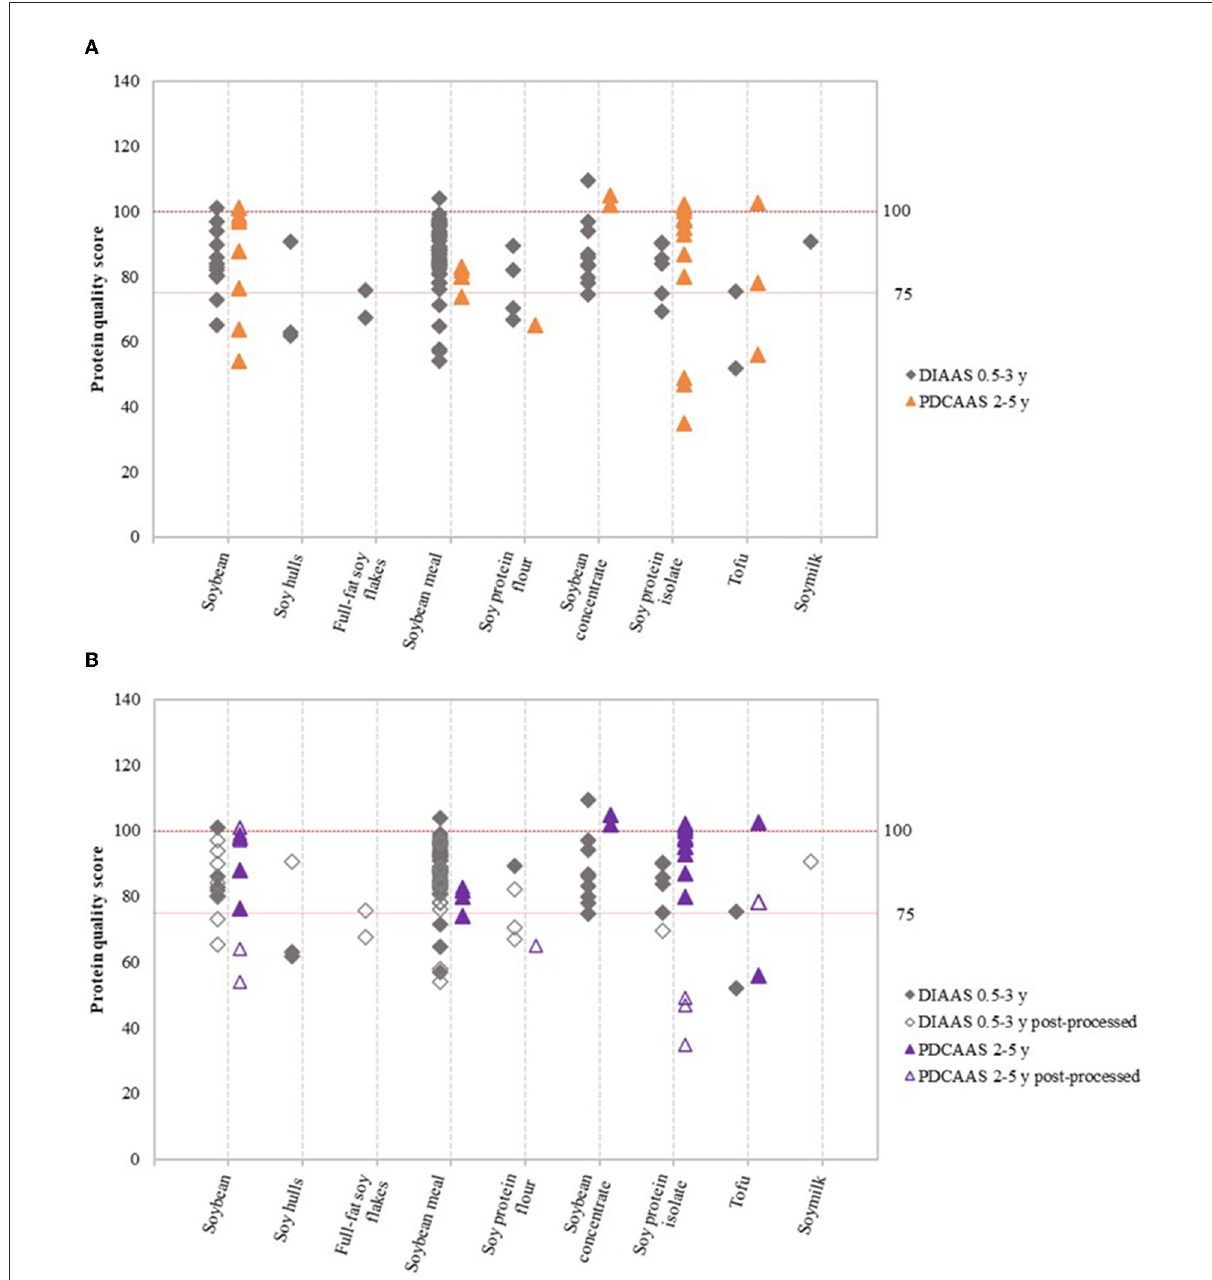
FIGURE2 Variation in DIAAS and PDCAAS of soy product groups (A) , and variation in DIAAS and PDCAAS based on classification as either non-post-processed or post-processed soy product (B) . DIAAS calculated for reference scoring patterns of children aged 0.5–3 years [2013 FAO report (4)] and PDCAAS for reference scoring patterns of children aged 2–5 years [1985 WHO report (15)].